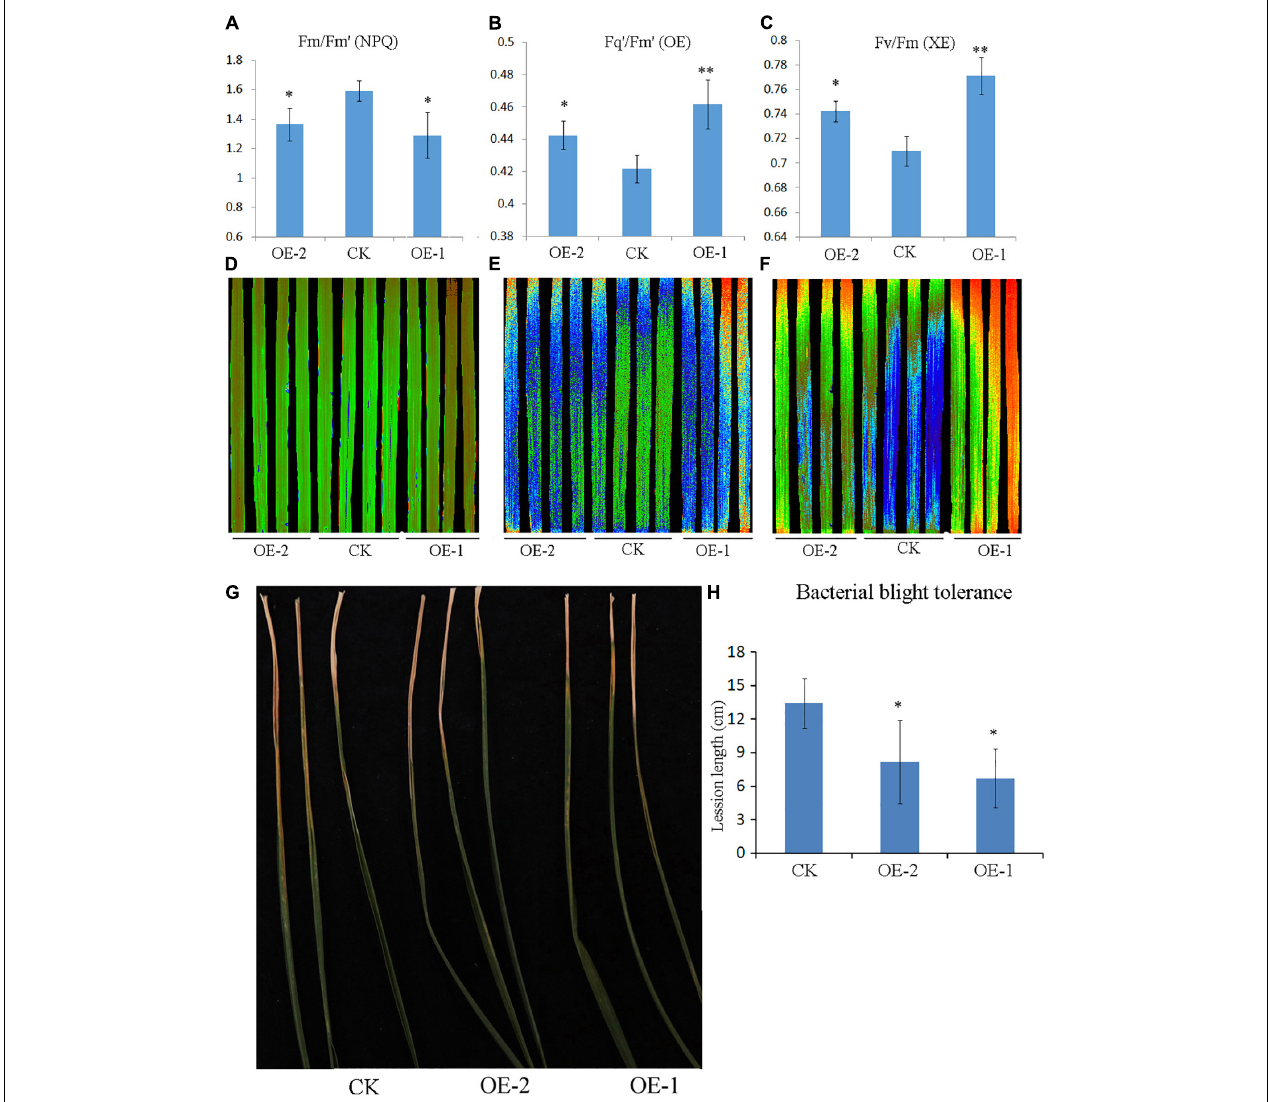
FIGURE 7 | Chlorophyll fluorescence and bacterial blight resistance assay of PpBURP2 transgenic plants. (A–F) Leaf photosynthetic apparatus was detected using chlorophyll fluorescence imaging. Quantification (A) and image (B) of Fm/Fm’, quantification (B) and image (E) of Fq’/Fm’, and quantification (C) and image (F) of Fv/Fm were shown at the 6th hour of measurement. (G,H) Inoculation of seedlings at the four-leaf stage by bacterial blight. Images (G) and lesion length of leaves (H)